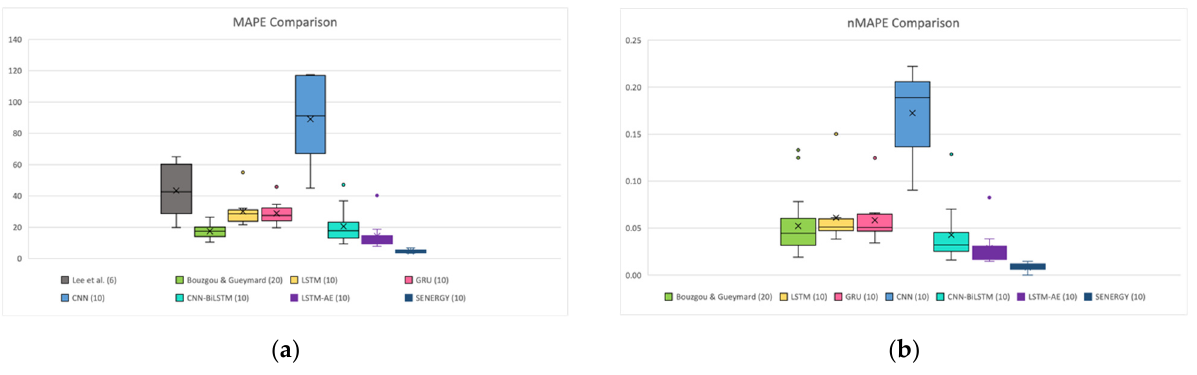
Figure 46. Comparison of multiple works based on: ( a ) MAPE; ( b ) nMAPE. In Figure 47a, FS MAE results of Gao et al. [24] are compared to the five forecasting models and the SENERGY results in this work. In this figure, the highest value is the best. It can be seen that the LSTM-AE model and SENERGY have the highest value and the lowest variation between locations, whereas the CNN model is the worst in terms of value and the CNN-BiLSTM model is the worst in terms of variation among locations. In (b), the FS RMSE results of three works, Gao et al. [24], Fouilloy et al. [25], and Bouzgou and Gueymard [30], are compared to the five forecasting models and SENERGY results in this work. Again, the LSTM-AE model and SENERGY have the highest value and the lowest variation between locations. The second best performance is achieved by the work of Gao et al. [24]. However, they only include the results of four locations, compared to ten